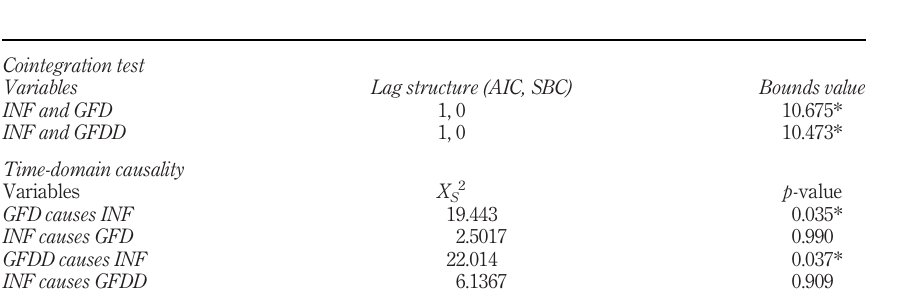
Table 4. Cointegration